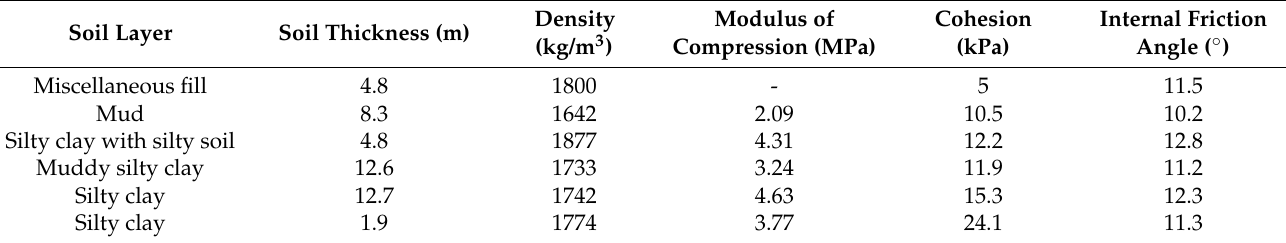
Table 2. Calculation parameters of the soil layers.